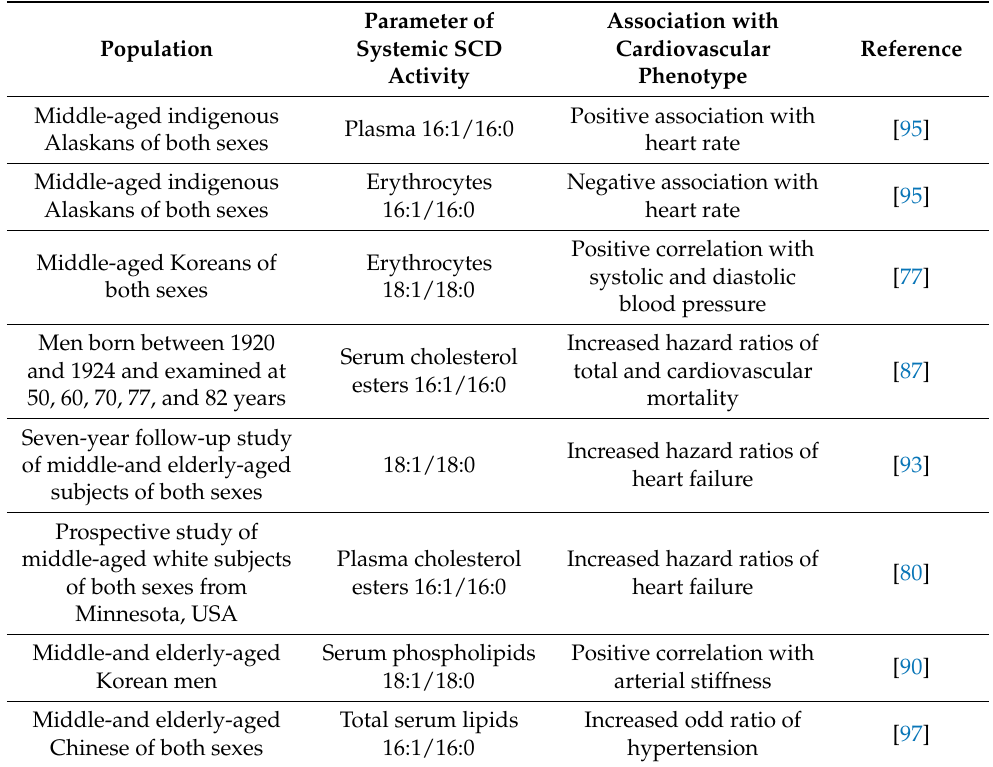
Table 1. Association of systemic SCD activity with cardiovascular phenotype. Association Parameter of Population Systemic SCD